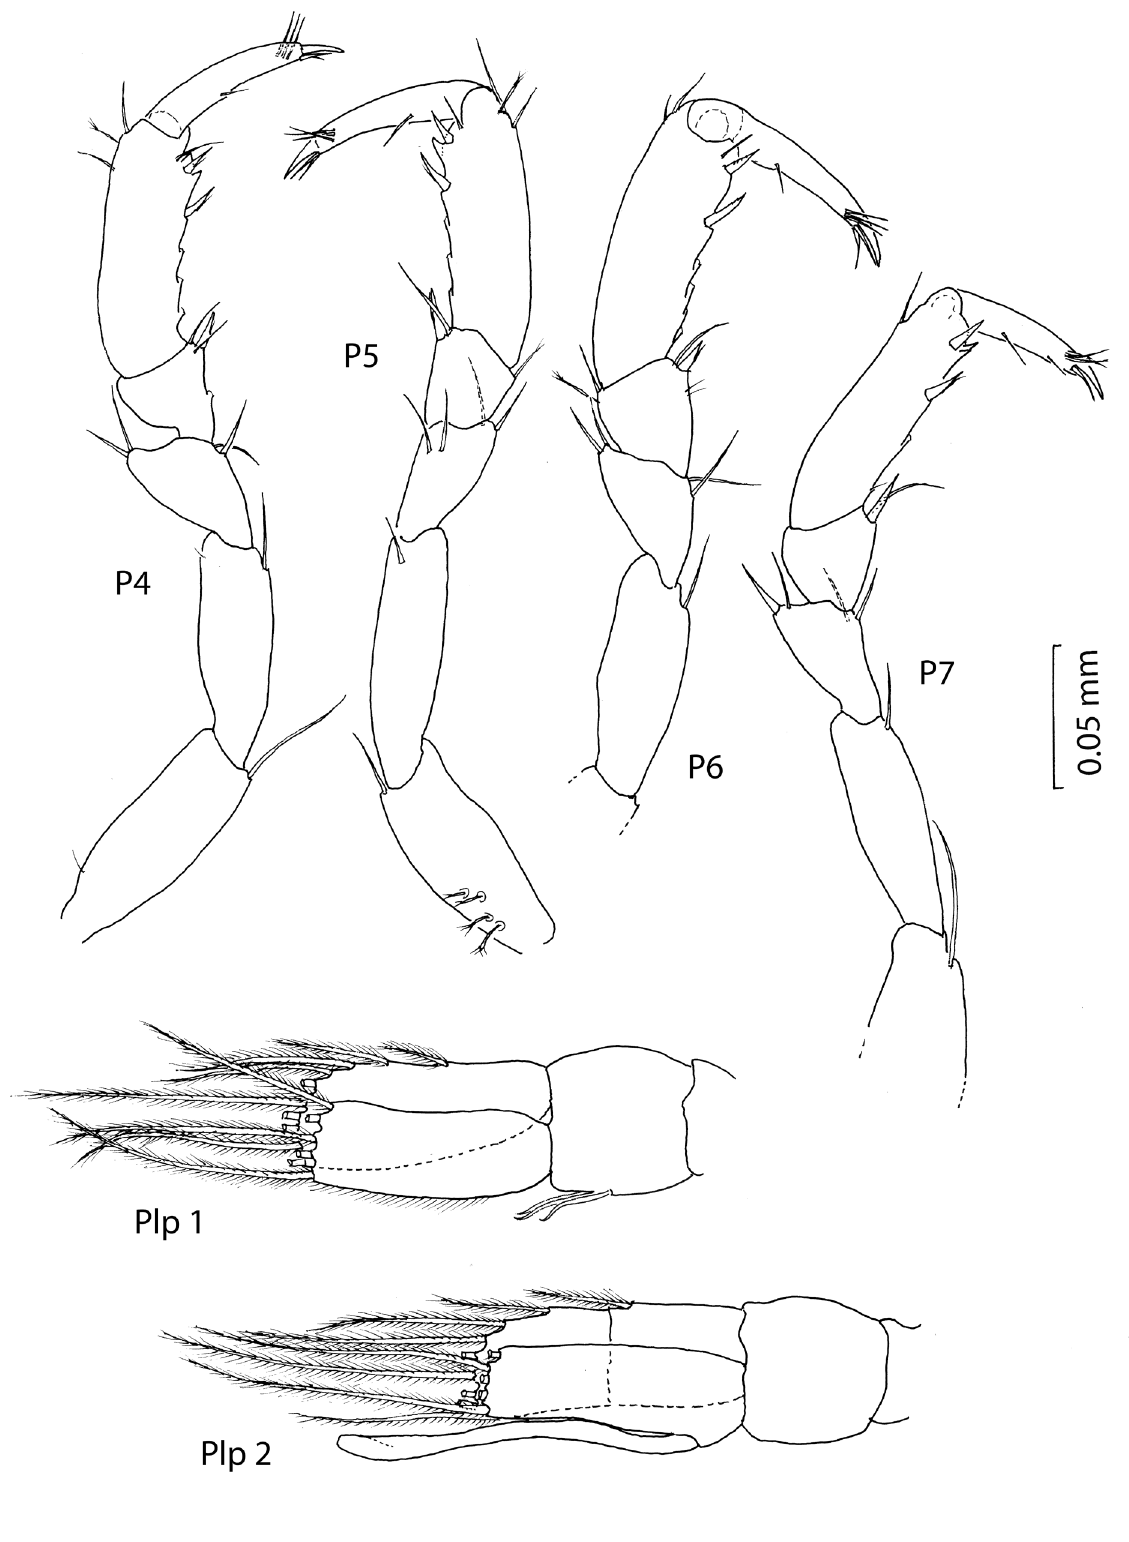
Fig. 4. Hyssura reptans sp. nov., ♂, holotype (MZB Iso 099) . Abbreviations: P4–P7 = pereopods 4–7; Plp1–2 = pleopods